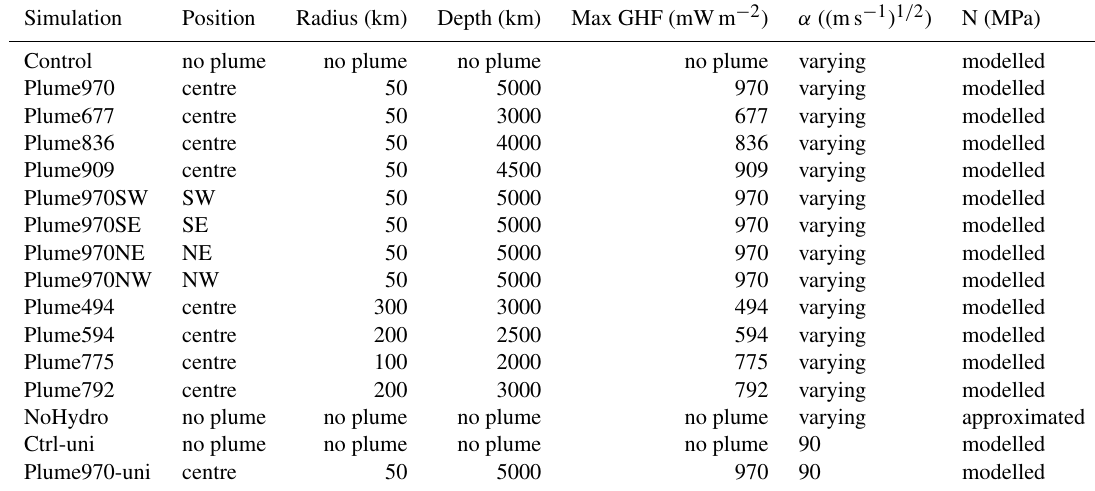
Plume494 centre Plume594 centre Plume775 Plume792 NoHydro no plume no plume no plume no plume varying approximated Ctrl-uni no plume no plume no plume no plume Plume970-uni